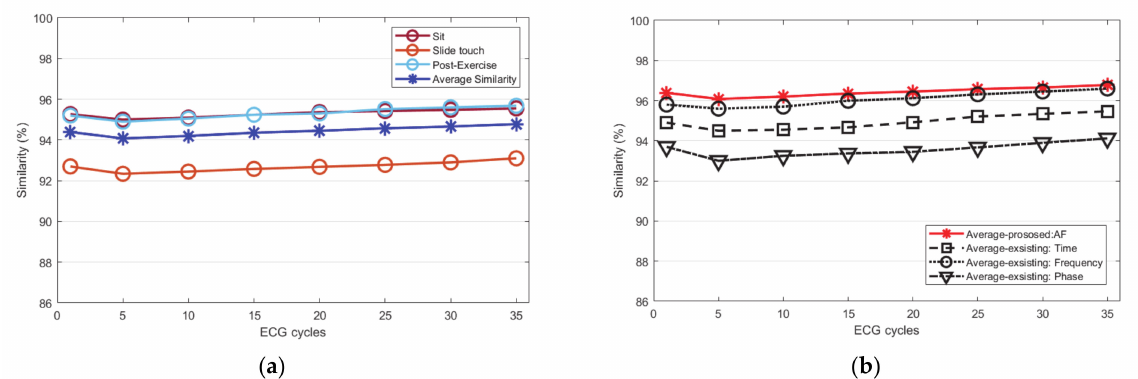
Figure 13. Cosine similarity performance analysis: ( a ) similarity of each status before normalization ( b ) similarity after normalization (proposed method, existing